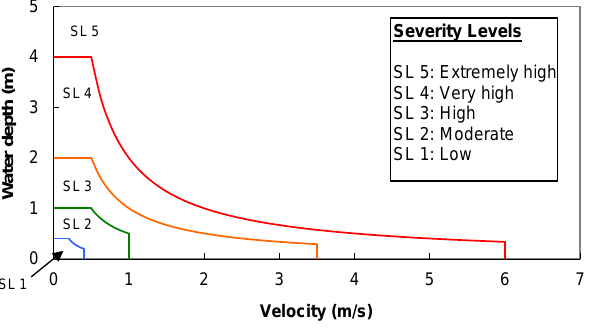
Fig. 18. Flood severity levels (adapted from Gracia et al., 2010).